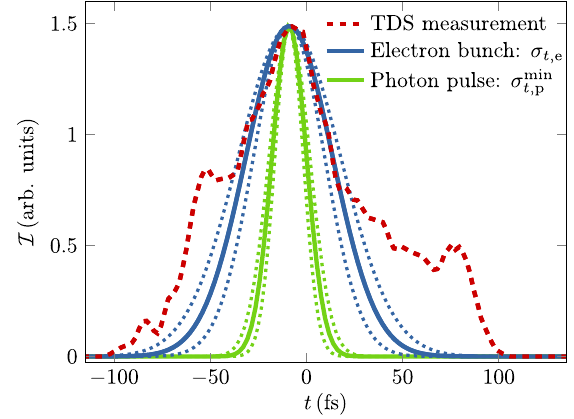
FIG. 9. Single-shot longitudinal electron bunch profile mea- surement using the TDS for a bunch charge of 150 pC (dashed red line). The selected single shot represents a typical bunch out of 50 measurements [cf. Fig. 5(a)] with an rms bunch length of ¼ 41 (cid:2) 2 fs . The blue solid (dotted) line shows a Gaussian (cid:2) t; e with (cid:4) ¼ 23 (cid:2) 4 fs representing the width (cid:4) t; e of a potential lasing part of the electron bunch. The green solid (dotted) line ffiffiffiffiffiffiffiffiffiffi p 2 ln2 Þ fs representing shows a Gaussian with (cid:4) ¼ ð 23 (cid:2) 4 Þ = ð 2 the corresponding soft x-ray (photon) pulse duration (cid:4) min t;p . The dotted lines describe the error bands ( (cid:2)